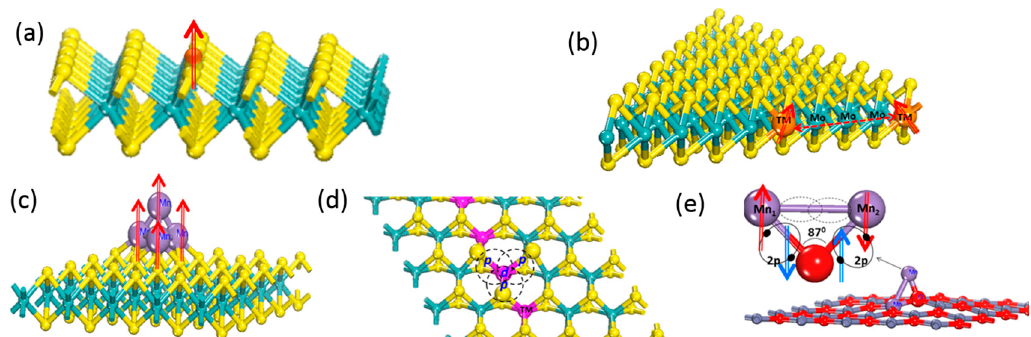
Figure 7. Magnetic interaction schemes. ( a ) Localization of net spin from the dopant contributes to the ferromagnetism of the system; ( b ) Two magnetic impurities are connected to the edge of the flake MoS 2 , shown as orange arrows; ( c ) direct exchange in Mn 4 cluster adsorbed on the MoS 2 monolayer; ( d ) superexchange in 3d δ -type doped monolayer MoS 2 ; and ( e ) superexchange and direct exchange competing in Mn atoms-doped-adsorbed ZnO monolayer.